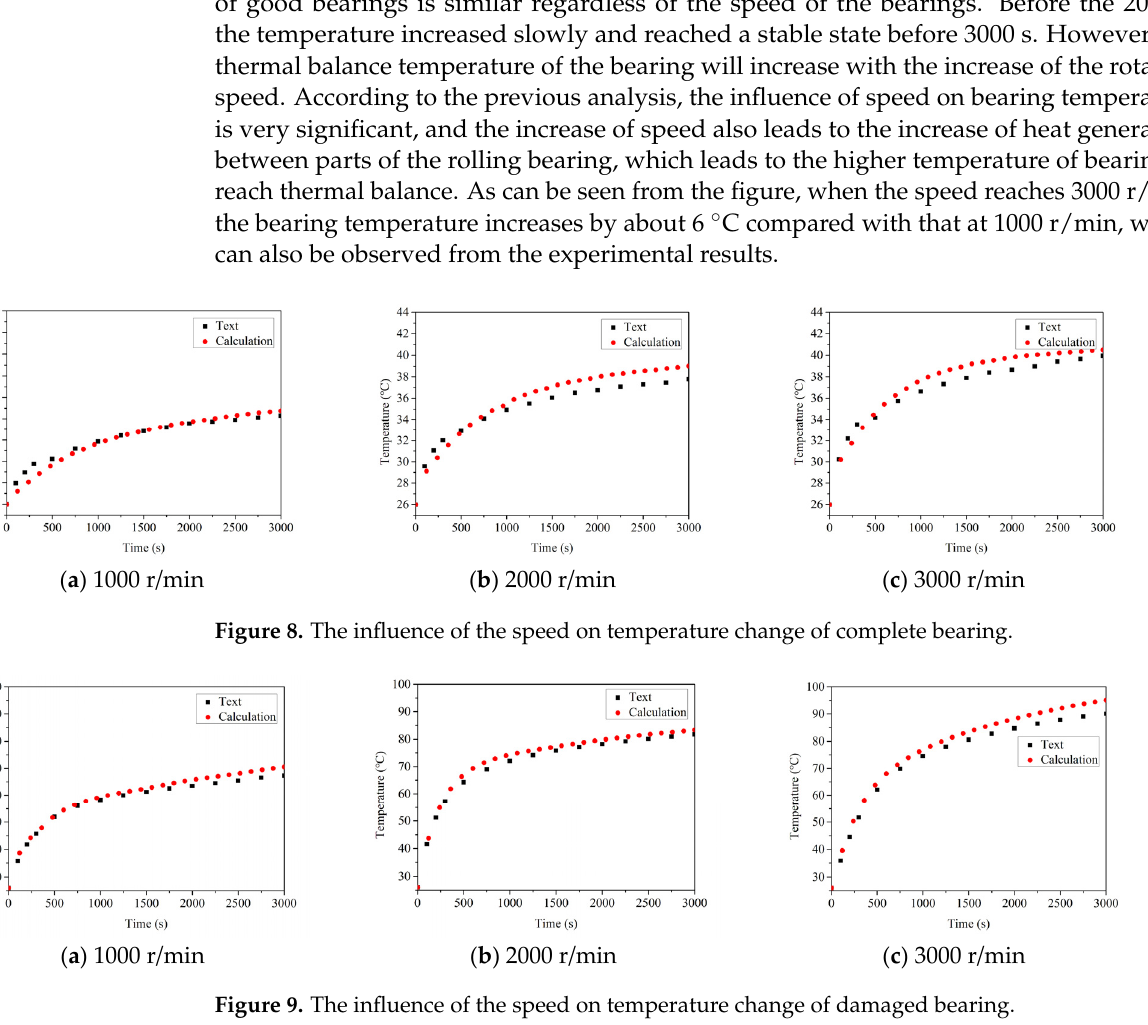
Figure 7. Schematic diagram of experimental platform structure.